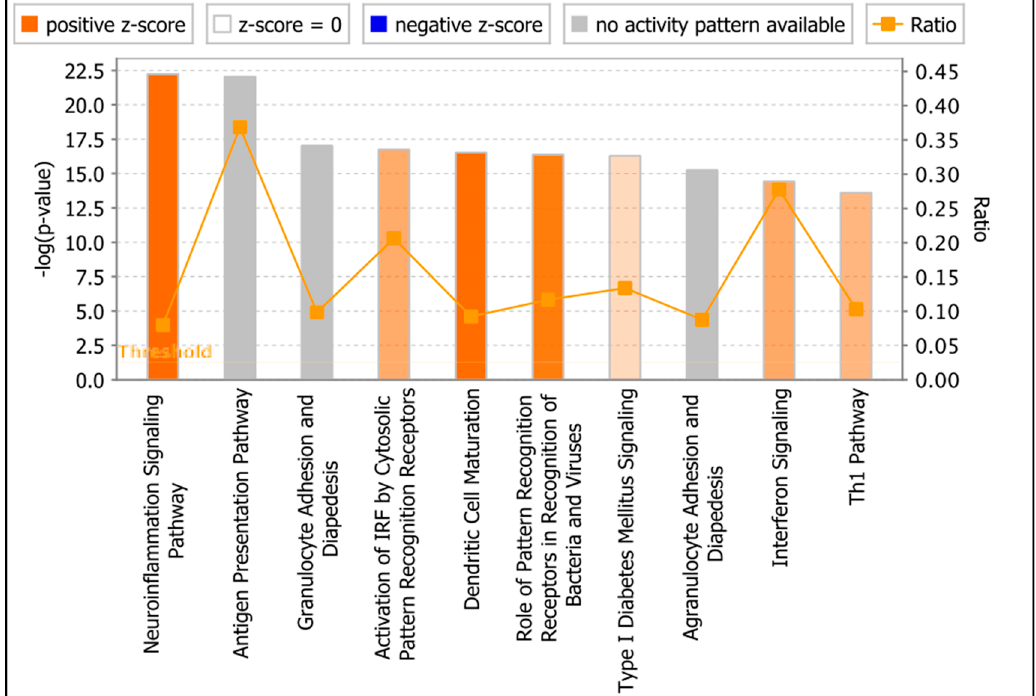
Figure 5. Core functional pathway analysis of ZIKV-modulated mRNAs using IPA. Top canonical signaling pathways regulated by significantly modulated mRNAs. Threshold bar indicates cut-off point of significance p < 0.05, using Fisher’s exact test. Range of activation z-score is also depicted in the figure. The color of the bars indicates predicted pathway activation based on z-score (orange = activation; blue = inhibition; gray = no prediction can be made; white = z-score close to 0). Orange line represents the ratio = number of genes in dataset/total number of genes that compose that pathway.